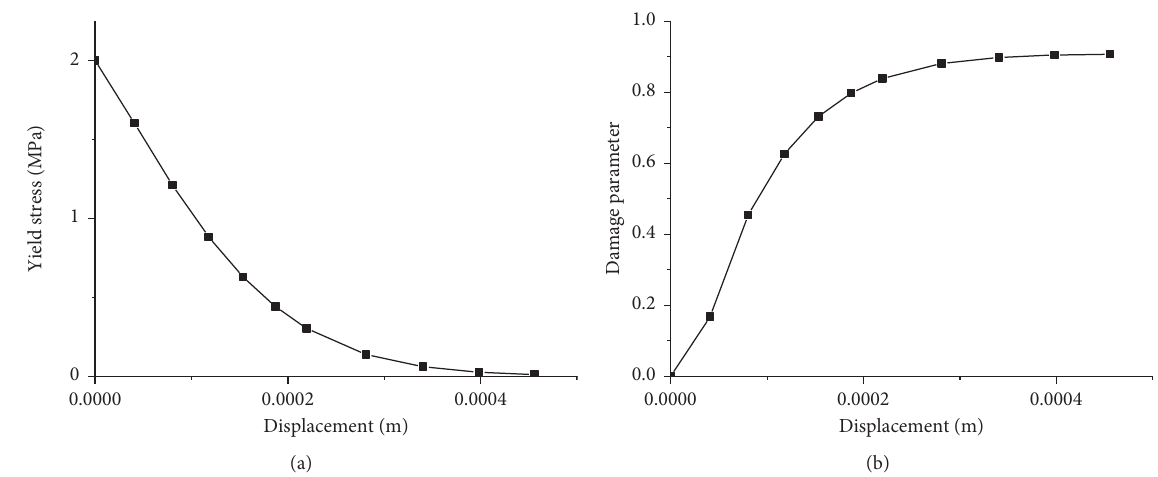
Figure 4: Dynamic tensile damage evolution curve of C